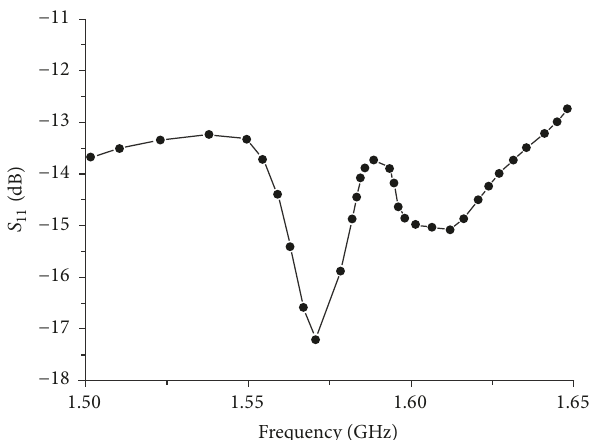
Figure 3: Reflection coefficient of antenna simulation unit.